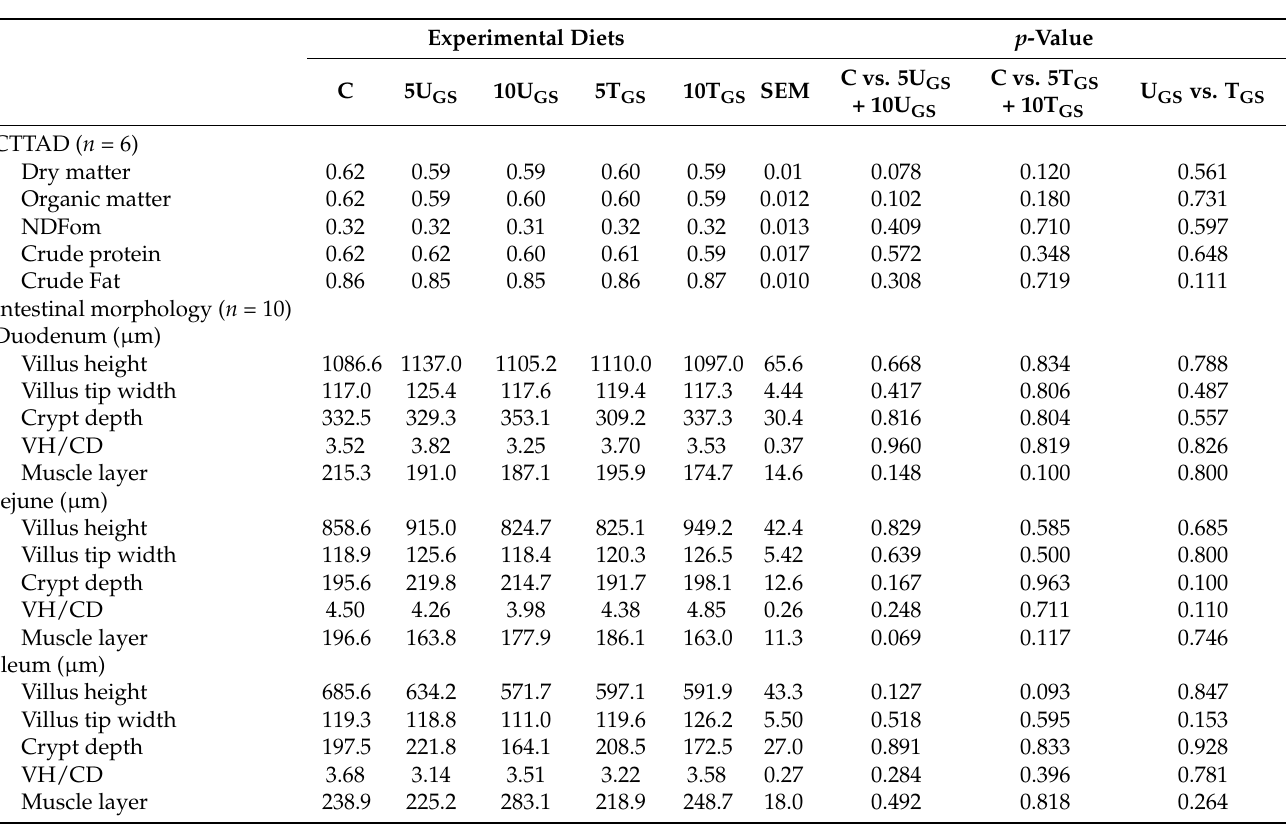
Table 3. Effect of the experimental diets on coefficients of total tract apparent digestibility (CTTAD, n = 6) and intestinal morphology of growing rabbits ( n = 10). Effect of the experimental diets on growth performance and carcass traits ( n =